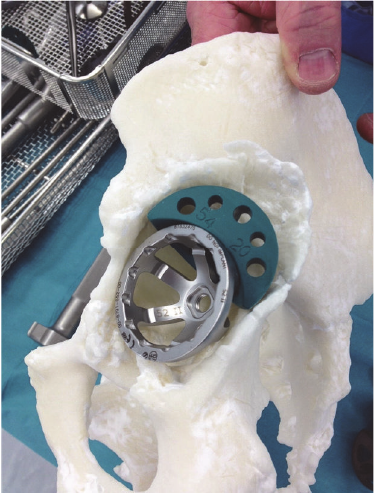
Figure 13: Preoperative templating, implant sizing, and surgi- cal stimulation (note: these figures in print journal are two- dimensional, thus limiting the true demonstration of the value of 3D printed models in providing an accurate understanding and repre- sentation of the complex deformities and corrective reconstructive